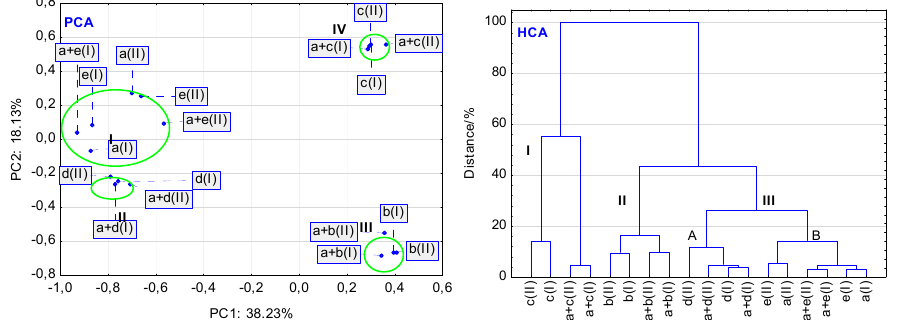
Figure 10. Findings of multivariate calculations using DSC data: PCA score scatter plot, and HCA tree diagram. Linagliptin = a(I) and a(II), lactose = b(I) and b(II), mannitol = c(I) and c(II), magnesium stearate = d(I) and d(II), and polyvinylpyrrolidone = e(I) and e(II). Physical mixtures of linagliptin with lactose = a + b(I) and a + b(II), mannitol = a + c(I) and a + c(II), magnesium stearate = a + d(I) and a + d(II), and polyvinylpyrrolidone = a + e(I) and a + e(II). (I and II) denote the non-stressed and stressed samples,